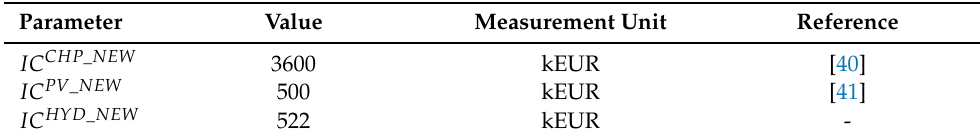
Table 9. Investment cost considered for each technology for